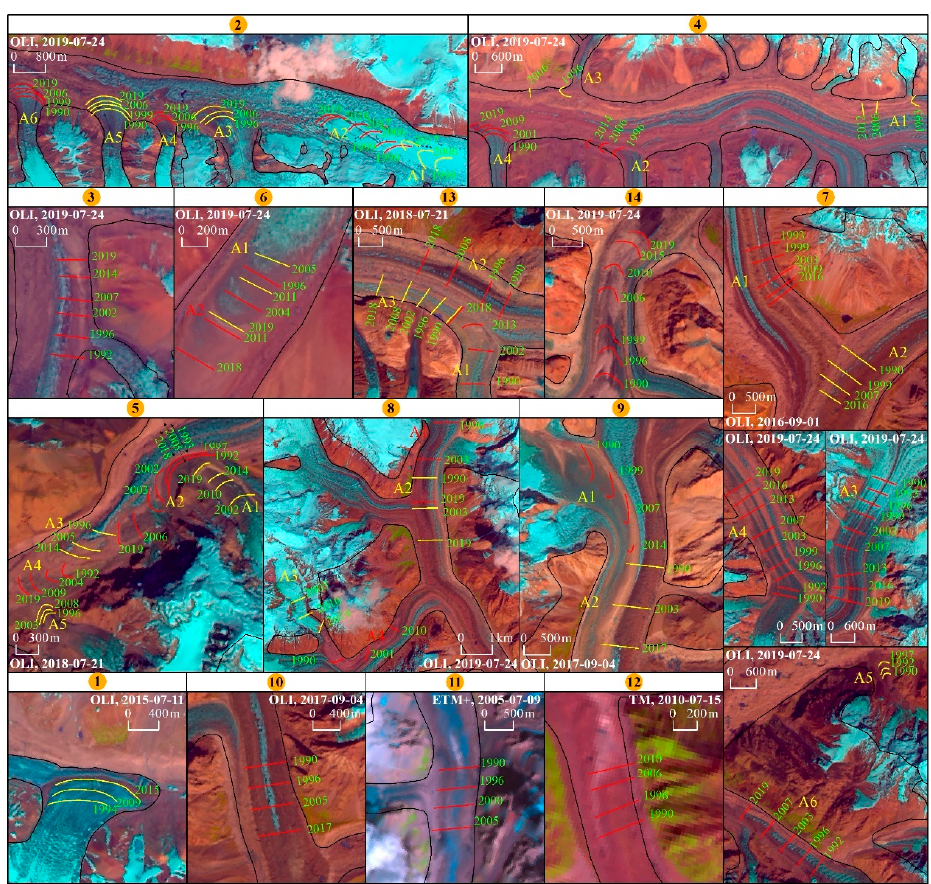
Figure 12. Timing of advancing glacial surface of the Tien Shan region. Figure shows locations for the year of advancing surface tributaries, trunk glaciers, labeled on remote sensing images of the most recent period of advancing glaciers in this sequence (including tributaries/trunks as follows) (refer Table 1 for glacier numbers): glaciers 2 (A1–6), 4 (A1–4), 3, 6 (A1–2), 13 (A1–3), 14, 7 (A1–6), 5 (A1–5), 8 (A1–3), 9 (A1–2), 1, 10, 11, and 12 using Operational Land Imager (OLI) imagery, except for glaciers 11 and 12, which used Enhanced Thematic Mapper (ETM+) and Landsat Thematic Mapper (TM) imagery, respectively. Table 3. Detailed information on the advance of tributary and trunk glaciers in the Tien Shan Range (surface advancing glaciers). Global Land Ice No. Measurements from Space ID